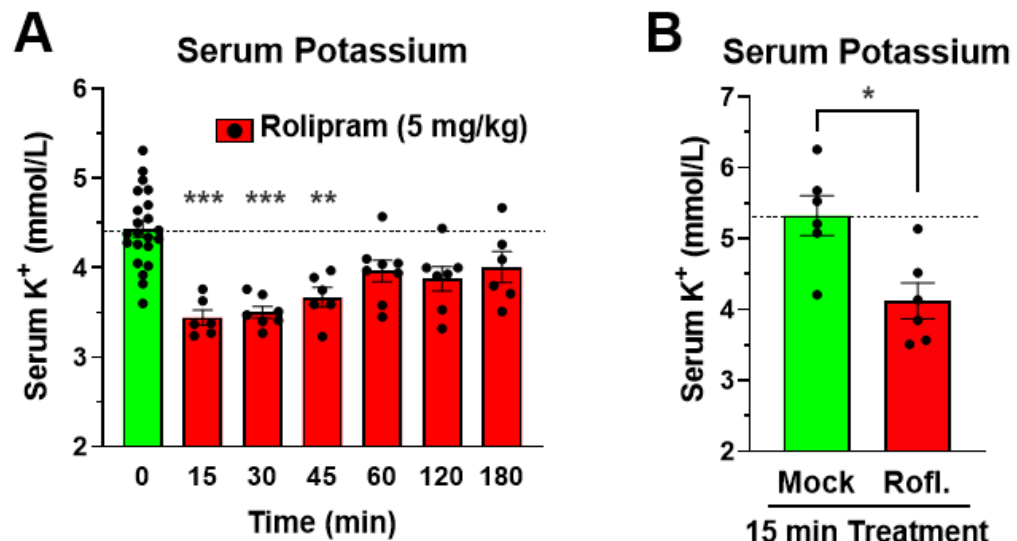
Figure 4. PDE4 inhibition produces a rapid-onset and transient reduction in serum potassium levels. ( A ) Mice were treated with the PDE4 inhibitor Rolipram (5 mg/kg, i.p.) for the indicated time periods before mice were bled to assess serum potassium levels. ( B ) Mice were treated with the PDE4 inhibitor Roflumilast (Rofl.; 5 mg/kg; i.p.) or solvent control (Mock) for 15 min before mice were bled to assess serum potassium levels. All data represent the mean ± SEM. Statistical significance was determined using Mann–Whitney tests (2 groups) or Kruskal–Wallis followed by Dunn’s post hoc tests (more than 2 groups) and is indicated as * ( p < 0.05), ** ( p < 0.01), and *** ( p < 0.001).